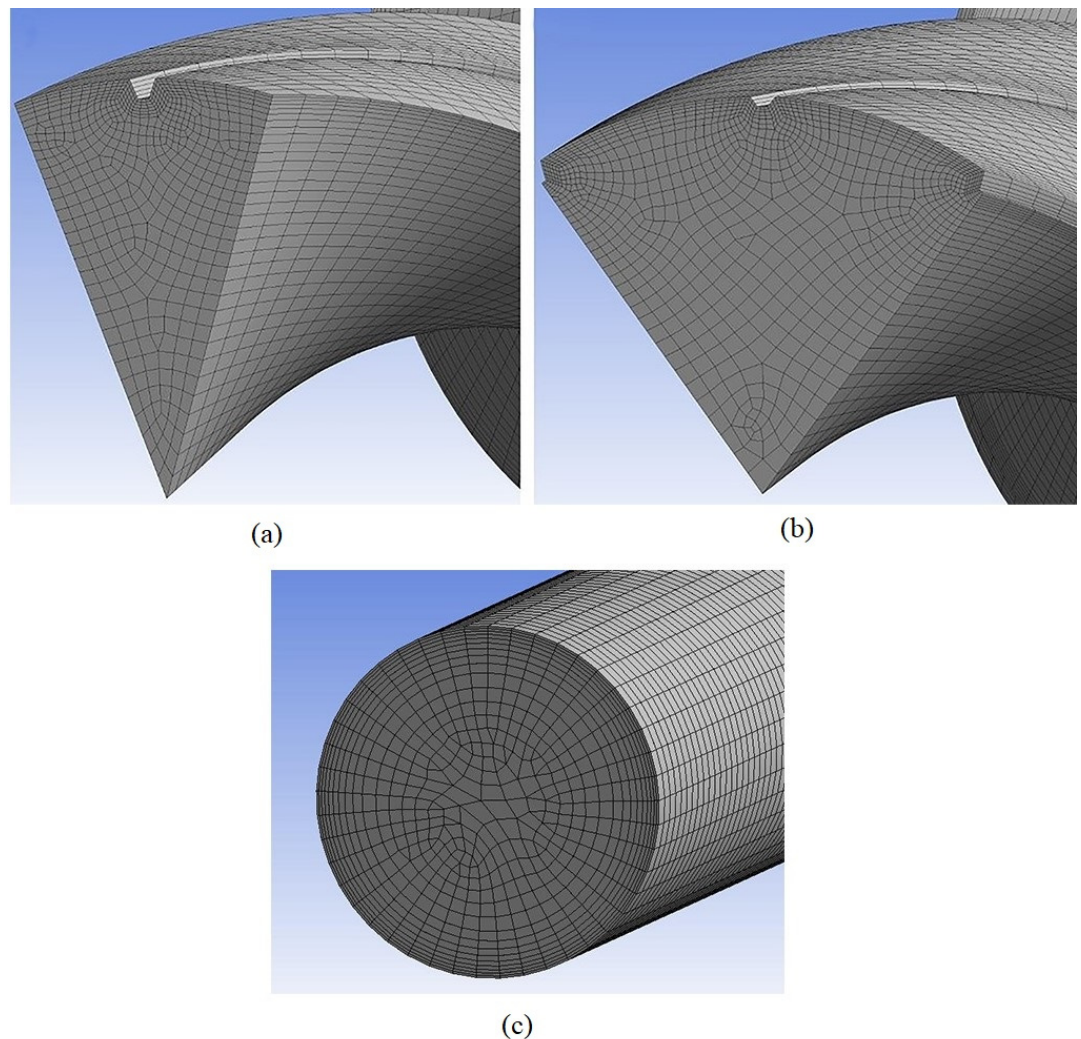
Figure 3. Mesh grid of fluid domain sector ( a ); Equal fin height; ( b ) Alternating fin height; and, ( c ) Smooth tube.